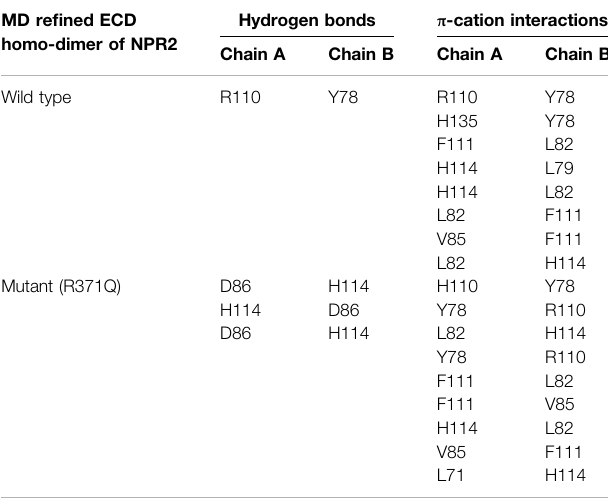
TABLE 1 | Molecular interactions between the MD re fi ned ECD homo-dimer of NPR2. MD re fi ned ECD homo-dimer of NPR2